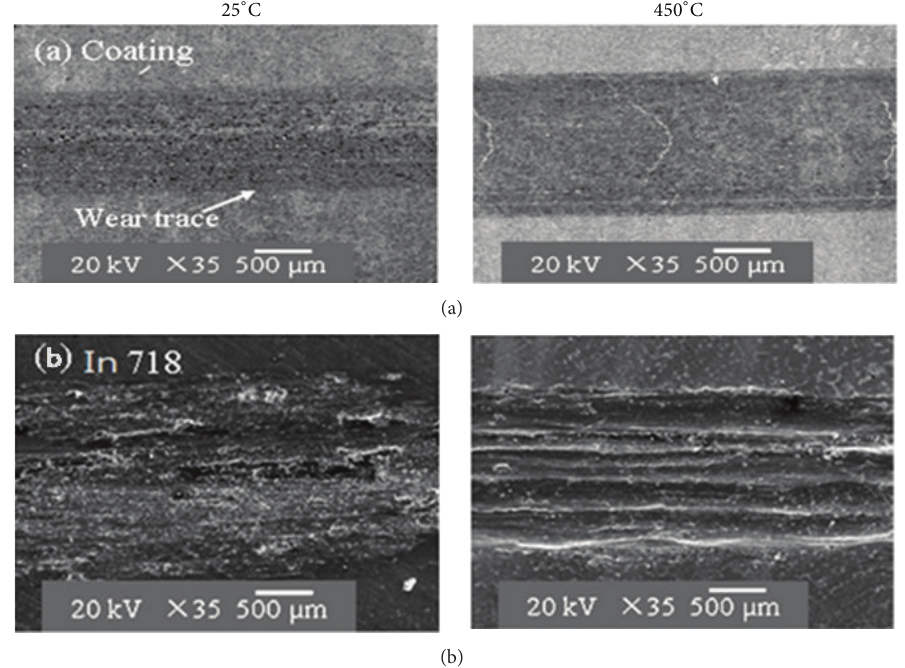
Figure 4: Wear traces of (a) coating and (b) In718 at both 25 ∘ C and 450 ∘